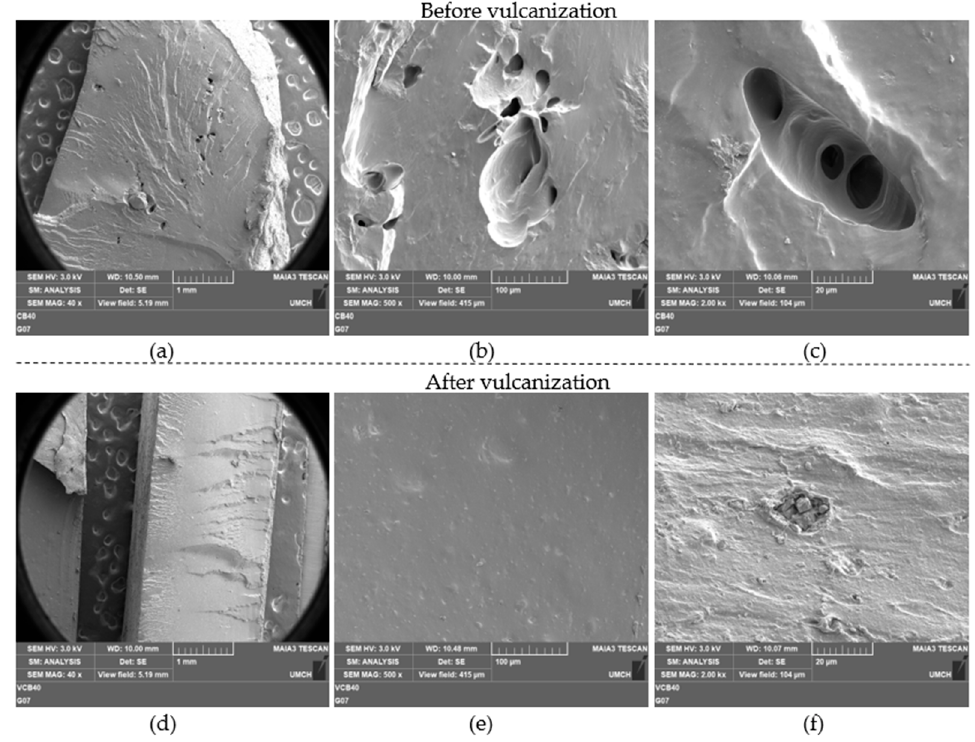
Figure 5. SEM images of the sample filled with 40 phr (25.16 wt.%) of hydrochar and 10 phr (6.29 wt.%) of carbon black: ( a – c ) unvulcanized state: sample CB40; ( d – f ) vulcanized state: sample VCB40; ( a , d ): really global view—1 mm scale bar; ( b , e ): 100 µm scale bar; and ( c , f ): 20 µm scale bar.